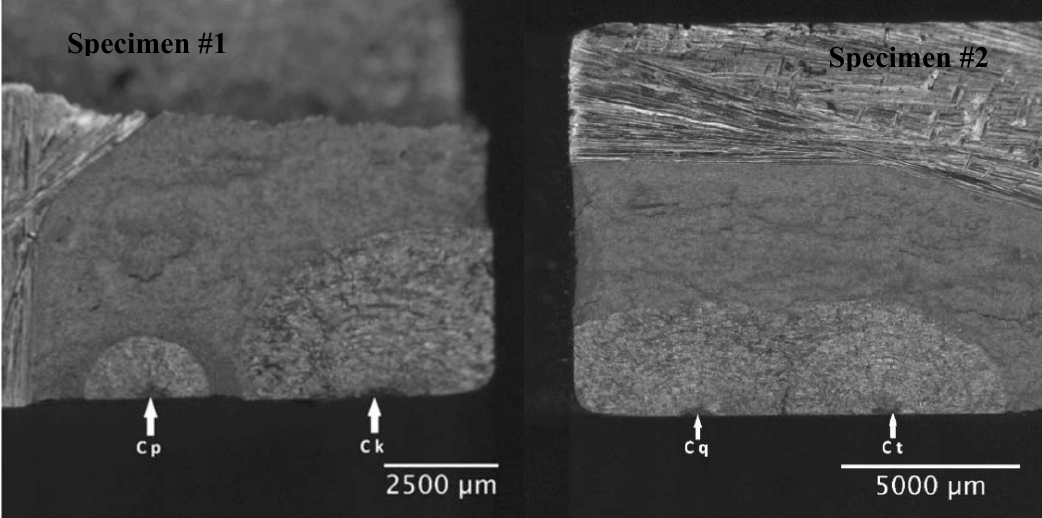
Figure 25. The two cracks on the manually opened surfaces of Specimen #1 (left) and Specimen #2 (right).